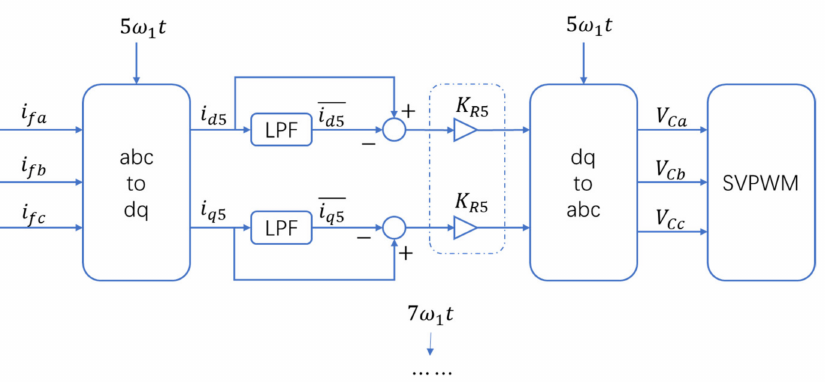
Figure 7. Block diagram of the zero-value impedance control system of the proposed HIAF